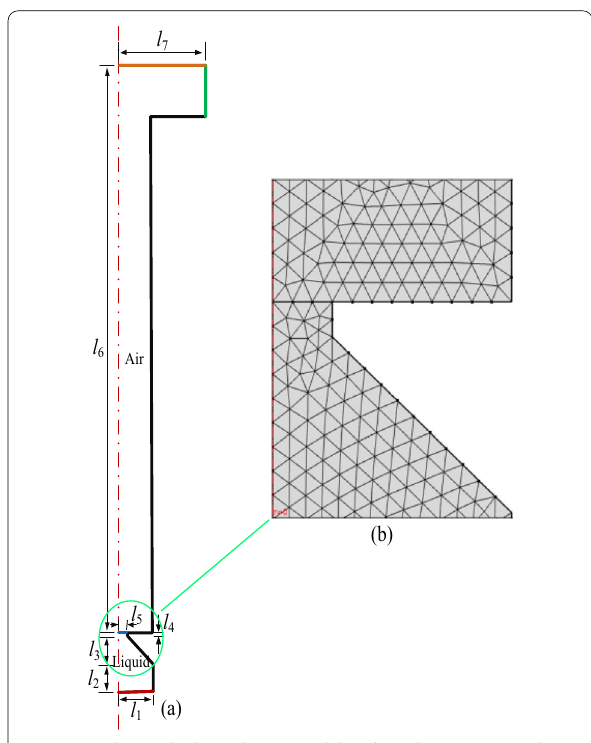
Figure 7 The applied simulation model and mesh partition used in CLSM method